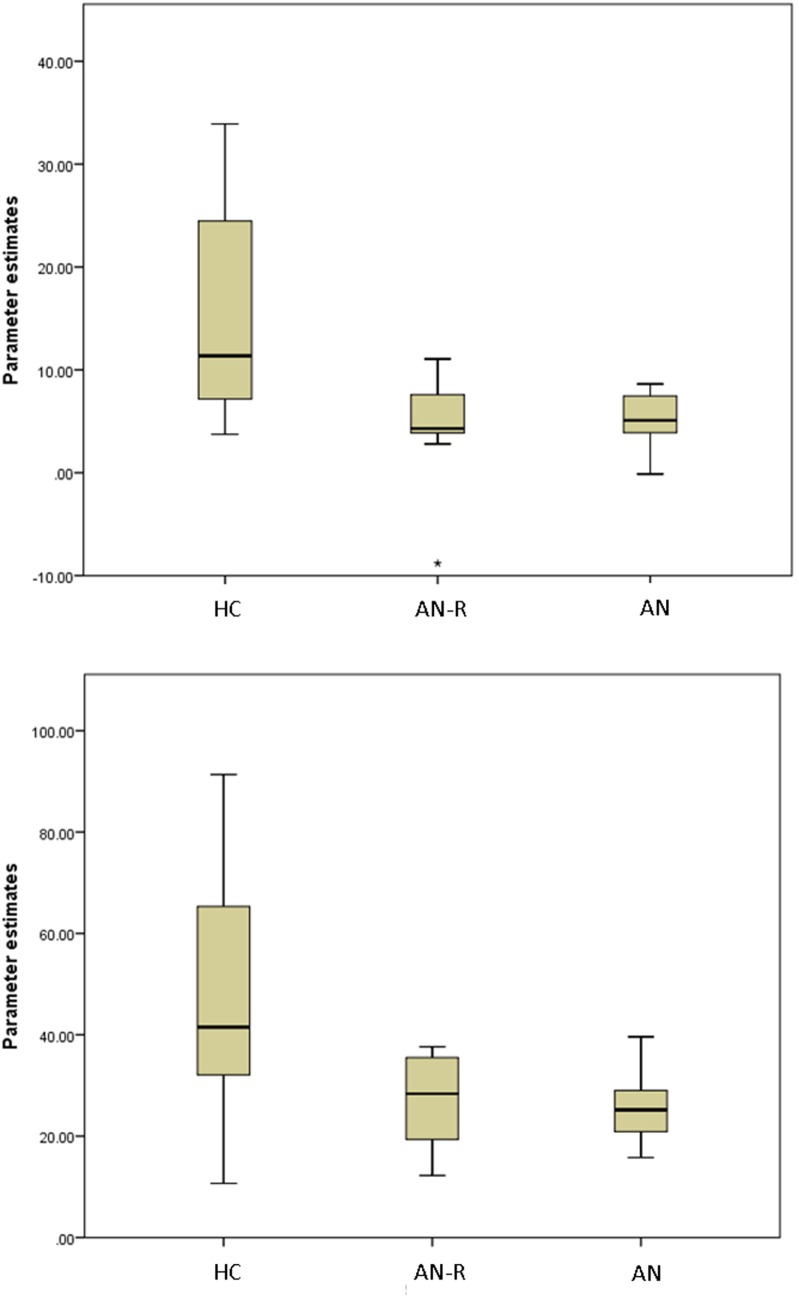
Box plots of extracted BETA values in the HC, AN-R and AN groups in the Lateral Visual Network (Top) and Auditory Network (Bottom). Asterisk represents an outlier in the group.